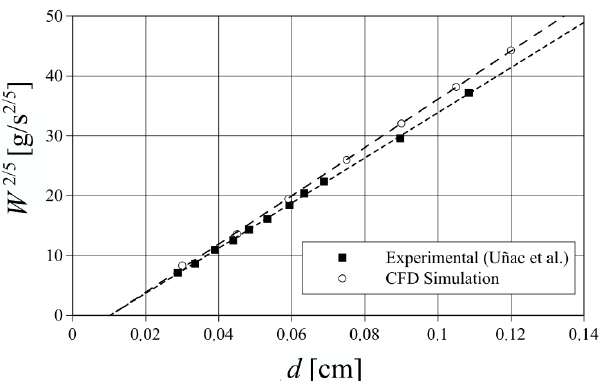
Figure 5. Silo discharge rate as a function of the outlet diameter: Experimental and CFD results with a linear